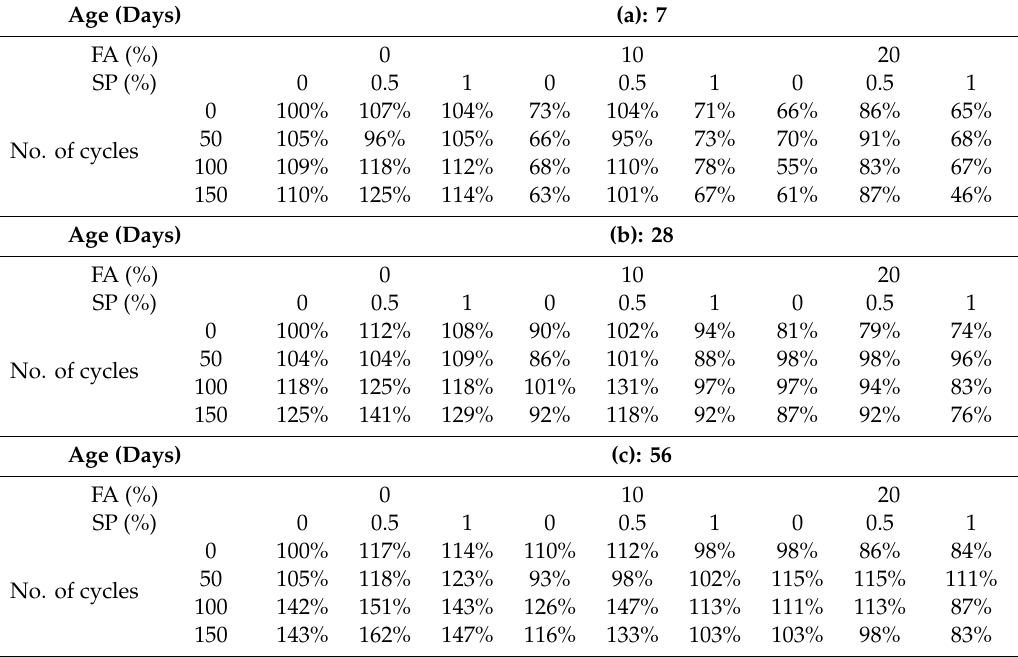
Table 7. Relative compressive strength of